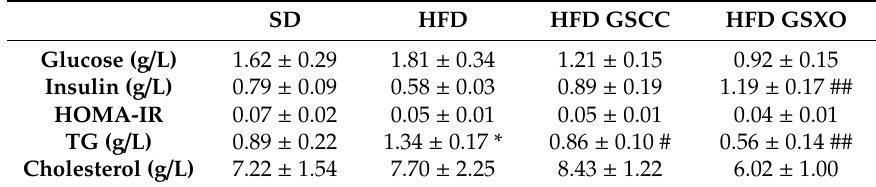
Table 2. E ff ect of diet and apple supplementation on glucose and lipid Table 2. Effect of diet and apple supplementation on glucose and lipid parameters.